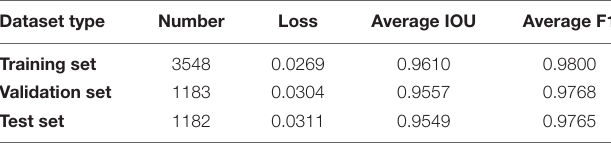
TABLE 2 | Performance of semantic segmentation model on training, verification, and test datasets. Dataset type